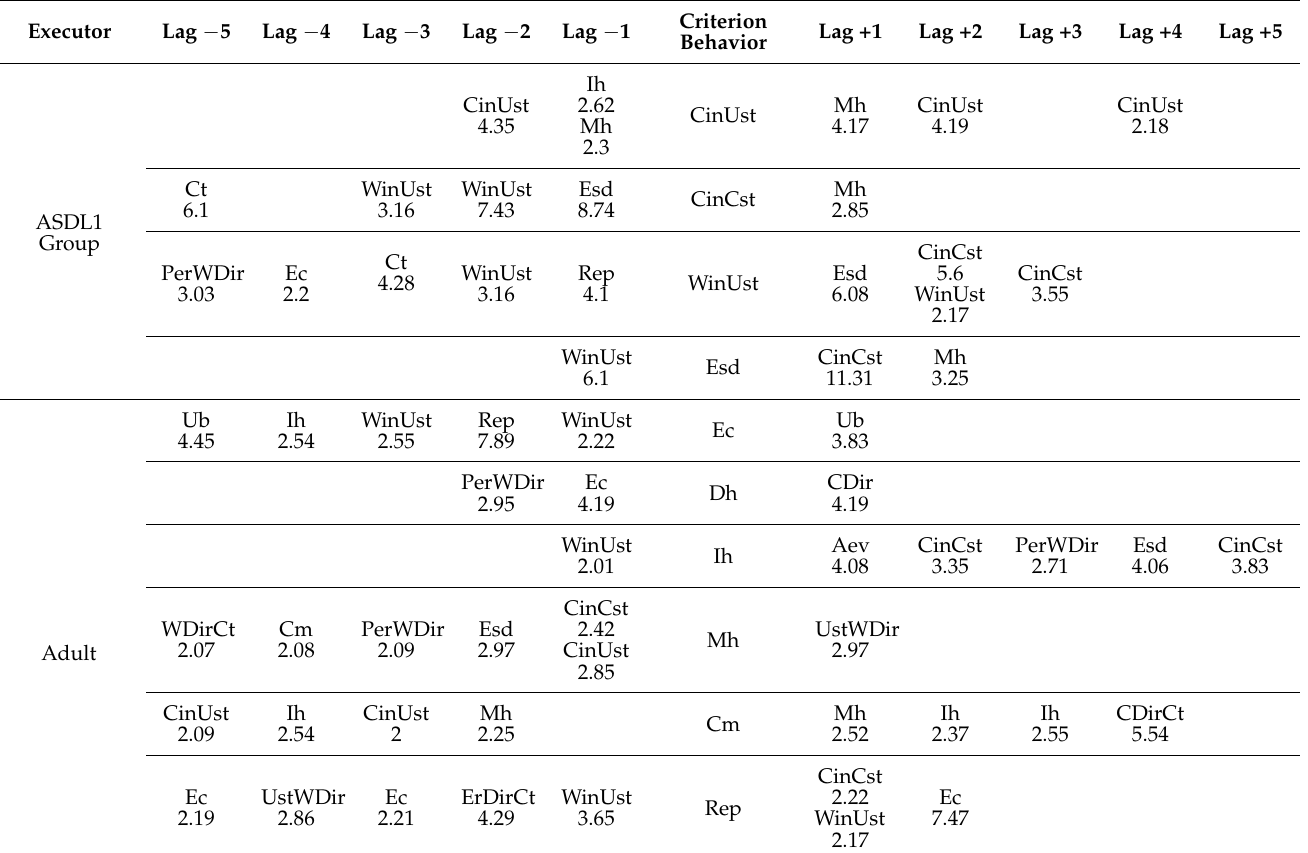
Table 4. Behavioral patterns obtained in the ASDL1 Group at the end of the intervention. Central column = It contains the criteria behaviors. Remaining cells = They contain the conditional behaviors. Numbers = Significant adjusted residuals values. Green codes = The most relevant behaviors indicating children progress in interference control. Red codes = The most relevant wrong interference control behaviors of the children. Blue codes = The most relevant adult scaffolding